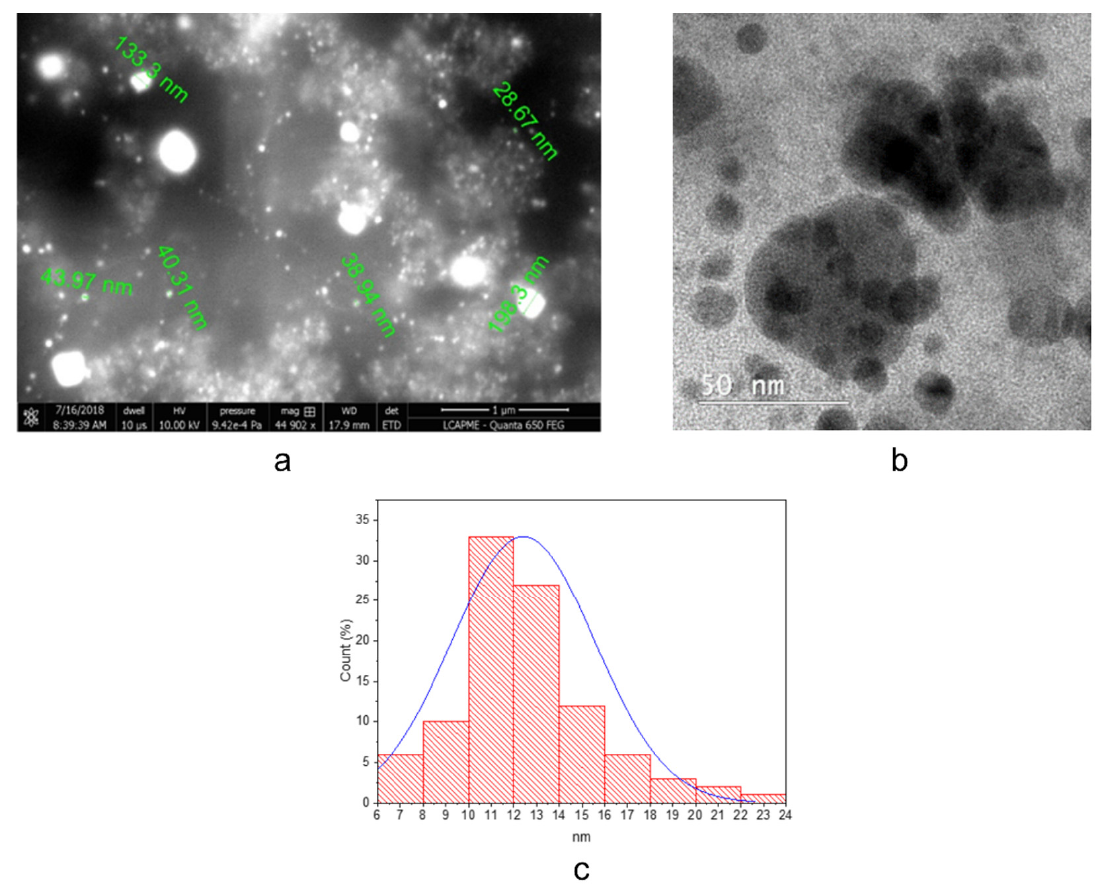
Figure 2. Morphological features of sample RS1N, as observed by SEM ( a ) and TEM ( b ) and size distribution of the particles, calculated from over 250 measurements from TEM images ( c ).